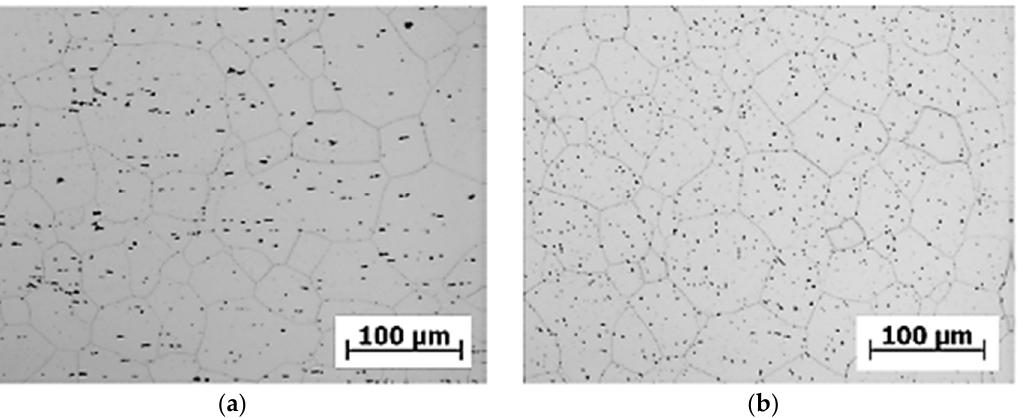
Figure 2. The microstructure of the selected alloy EN AW 6063.T66 in ( a ) the longitudinal direction, and ( b ) the transversal direction, etched by 0.5% HF.